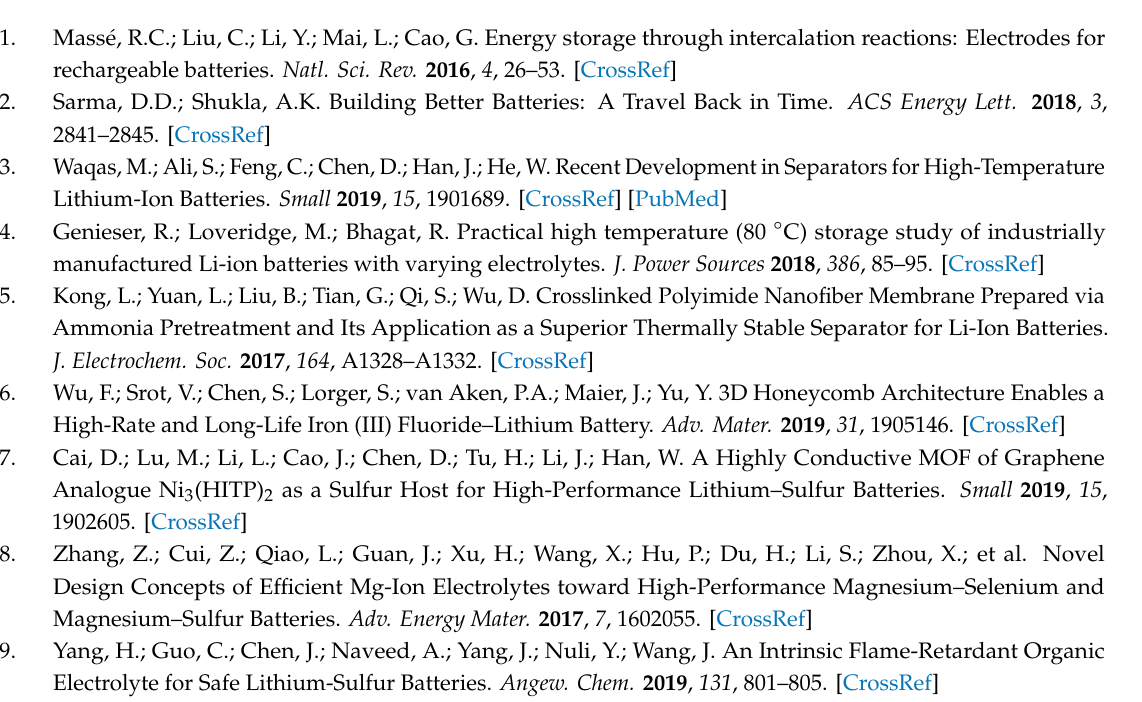
Figure S1: Size distribution; Figure S2: SEM image; Figure S3: CV curve; Figure S4: Equivalent electric